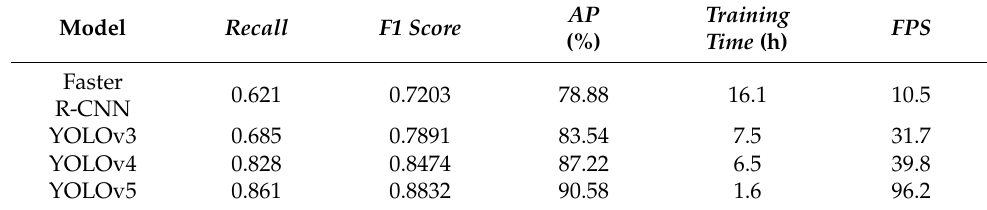
Table 8. Performance comparison of models on FLOW-Img public dataset.